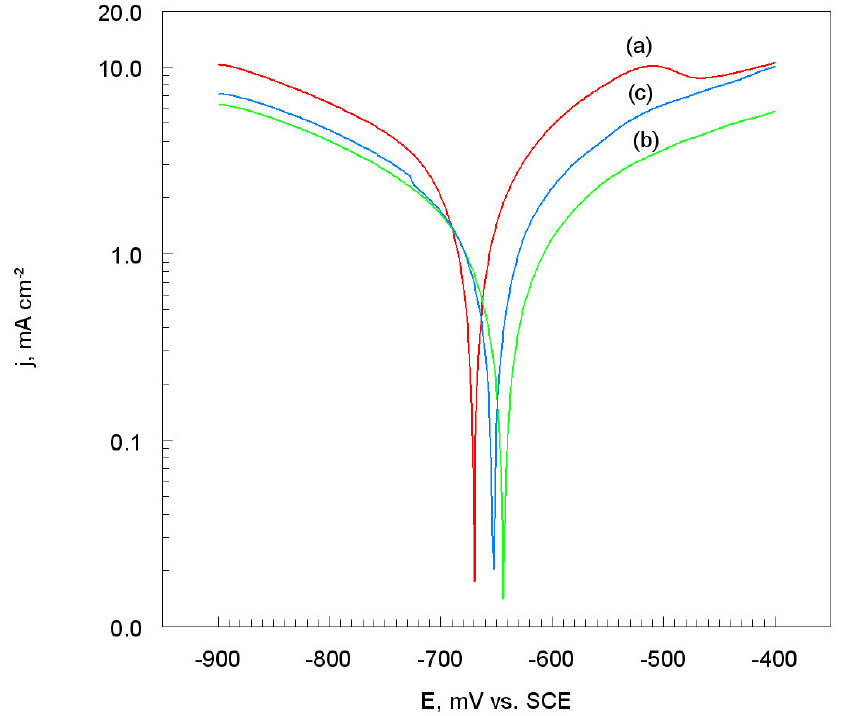
Figure 6. Potentiodynamic polarization curves on a semi-logarithmic (Tafel scale) of titanium coatings onto Al7075 substrate deposited at SoD of: ( a ) 20 mm, ( b ) 70 mm, and ( c ) 100 mm. Solutions contained 1.2 M Cl − , pH 1.5, dE/dt 1 mV s − 1 . Table 3. Corrosion electrochemical parameters of titanium coatings onto Al7075